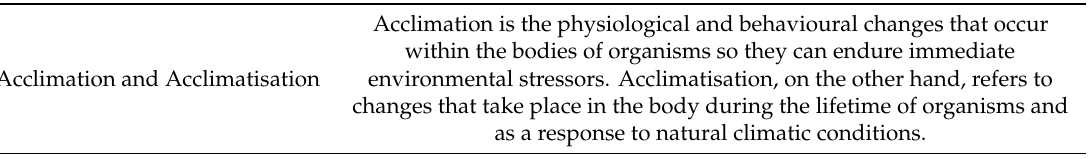
Table 1. Key physiological